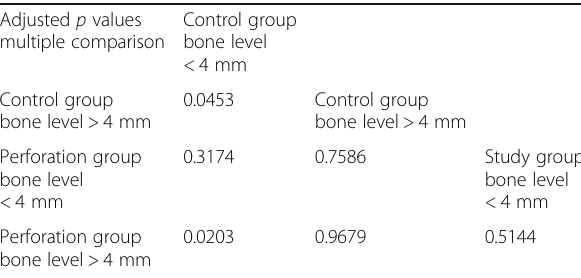
Table 4 Multiple comparisons of subgroups: postoperative bone level